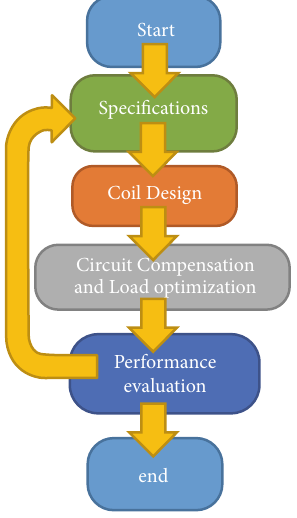
Figure 3: Adopted design